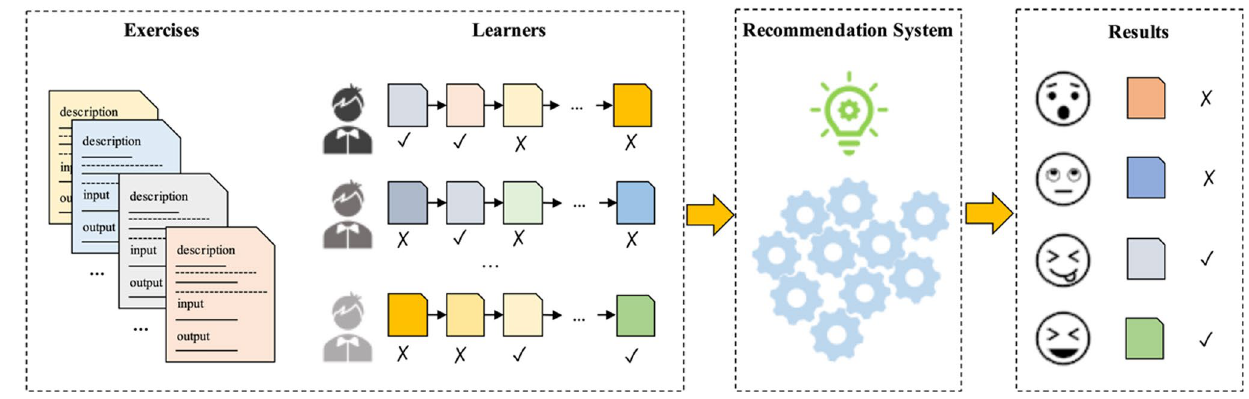
Fig. 1 Schematic diagram of online learning recommendation system: the interaction process between learners and the